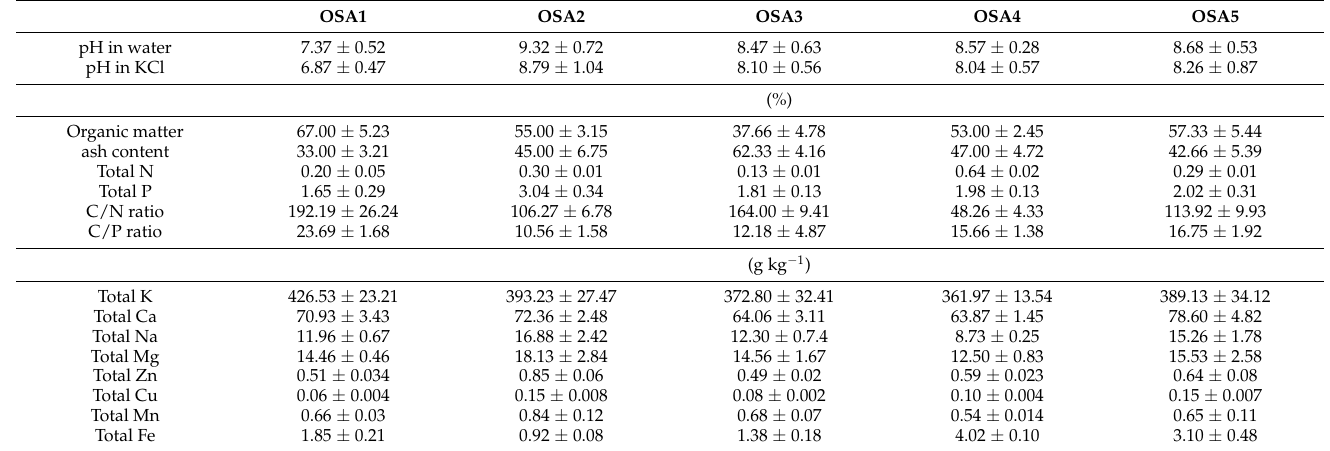
Table 2. Initial chemical properties of organic soil amendments.